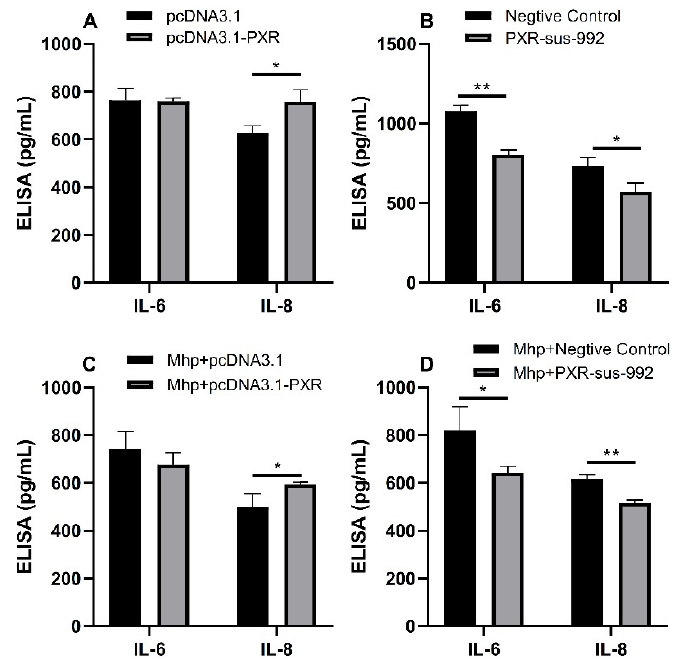
Figure 7. ELISA result of IL-6 and IL-8 protein in the cell culture supernatant of the PAM 3D4/21 cells. ( A ) The protein expression of IL-6 and IL-8 after PXR overexpression. ( B ) The protein expression of IL-6 and IL-8 after PXR silencing. ( C ) The protein expression of IL-6 and IL-8 after PXR overexpression with M. hyopneumoniae infection. ( D ) The protein expression of IL-6 and IL-8 after PXR silencing with M. hyopneumoniae infection. The data are presented as the mean ± SD. The experiment was repeated three independent times. * p < 0.05; ** p < 0.01.